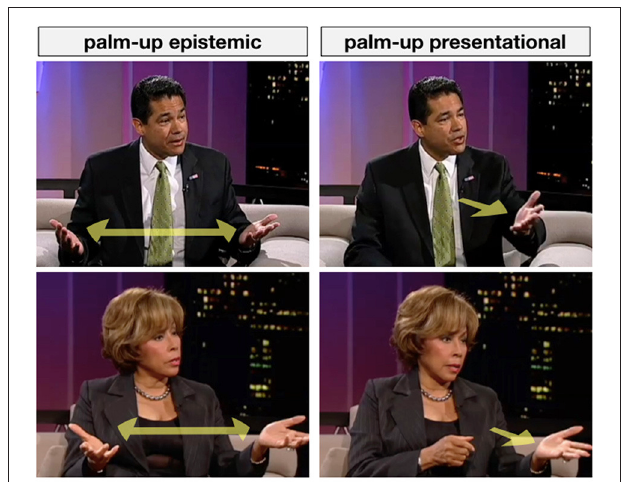
FIGURE 2 | Examples of two gestures within the palm-up form family. In English speakers, depicted here, these gestures prototypically involve different motion patterns. Palm-up epistemic gestures (Left) involve a lateral separation of the hands (or a lateral movement of one hand), and are used to express epistemic meanings. Palm-up presentational gestures (Right) prototypically involve a movement toward the interlocutor as if “presenting” an idea. Images reproduced under fair